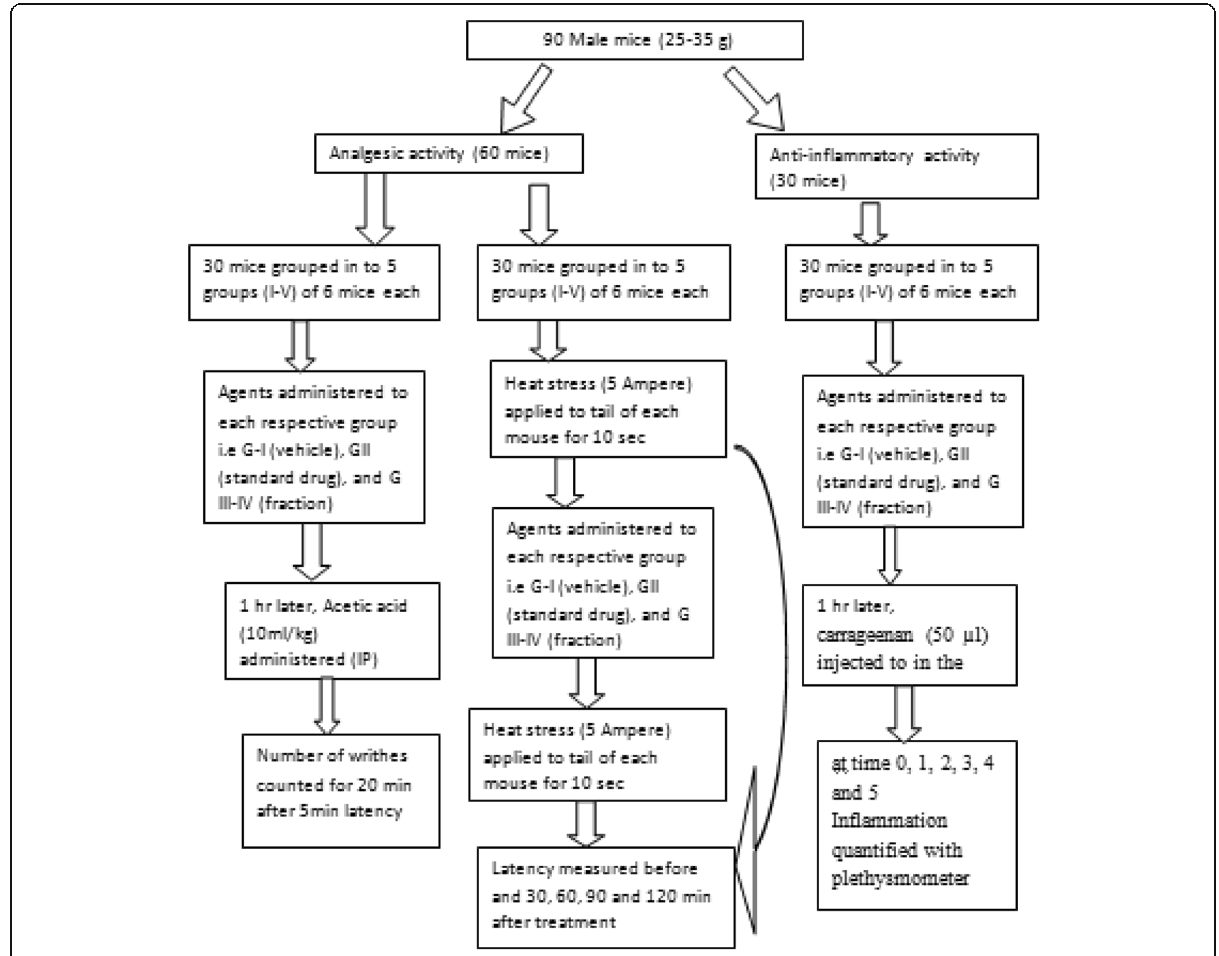
Fig. 1 Schematic presentation of the designed